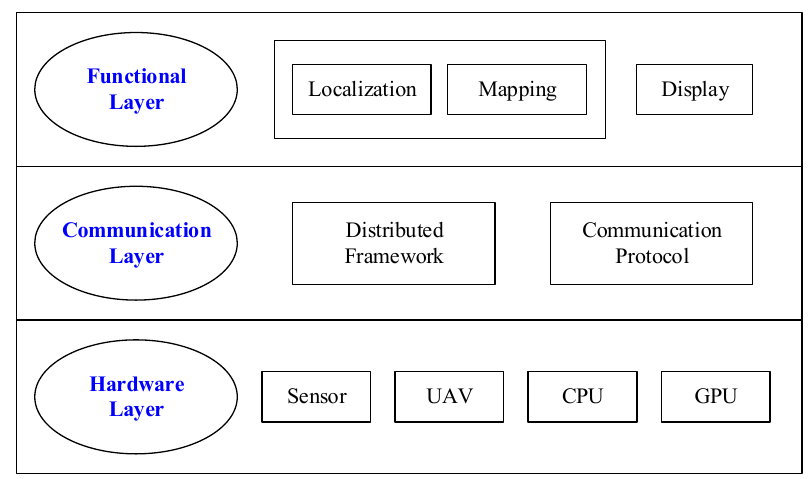
Figure 8. Overview of system architecture.